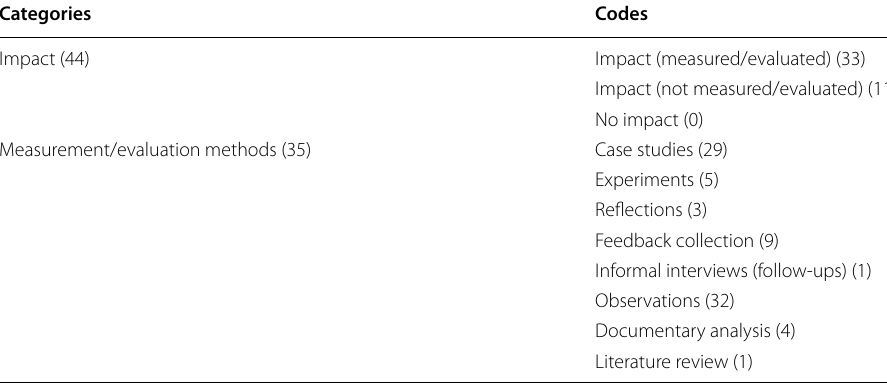
Table 7 Coding results on the impact of design thinking